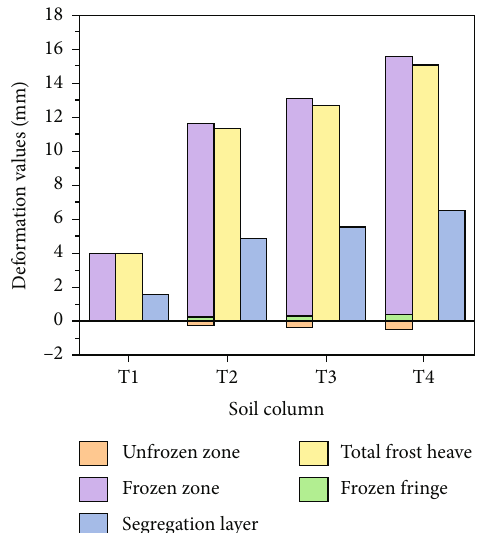
Figure 17: The frost heave deformation distributions of the soil